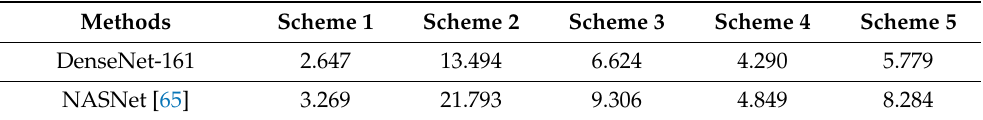
Table 6. Comparison of finger-vein recognition error (EER) with and without motion and optical blur application and restoration in SDU-DB according to different finger-vein recognition methods (unit: %) (random motion blur and optical blur with intensity 19 × 19 (Gaussian filter size) and 19 (Gaussian filter standard deviation)).